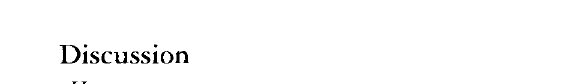
(Table 2). Mathiesen et al. (1987) found the pH